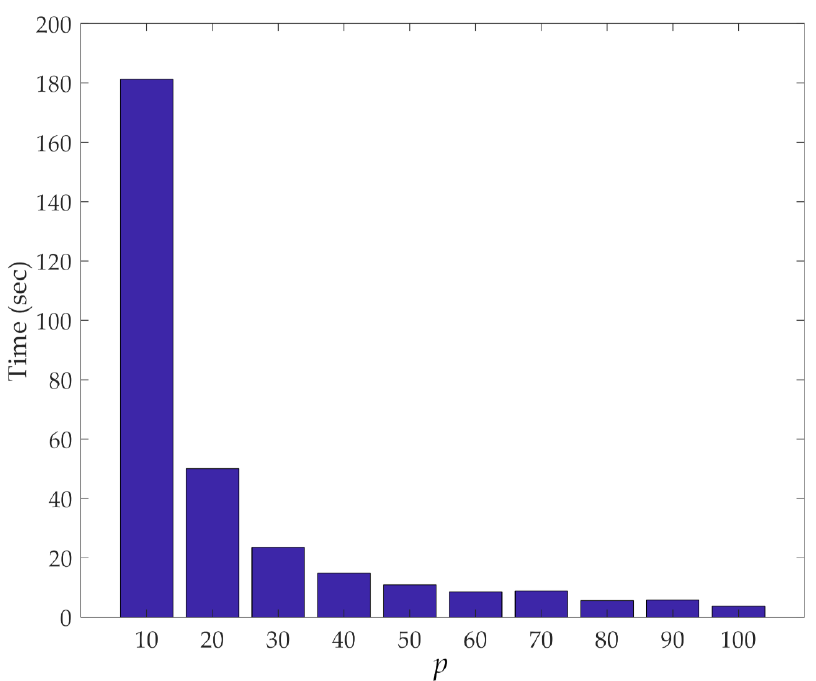
Figure 6. ASCE problem: effect of the number p of partitions on the computing time relevant to the iterative loops of the proposed method.